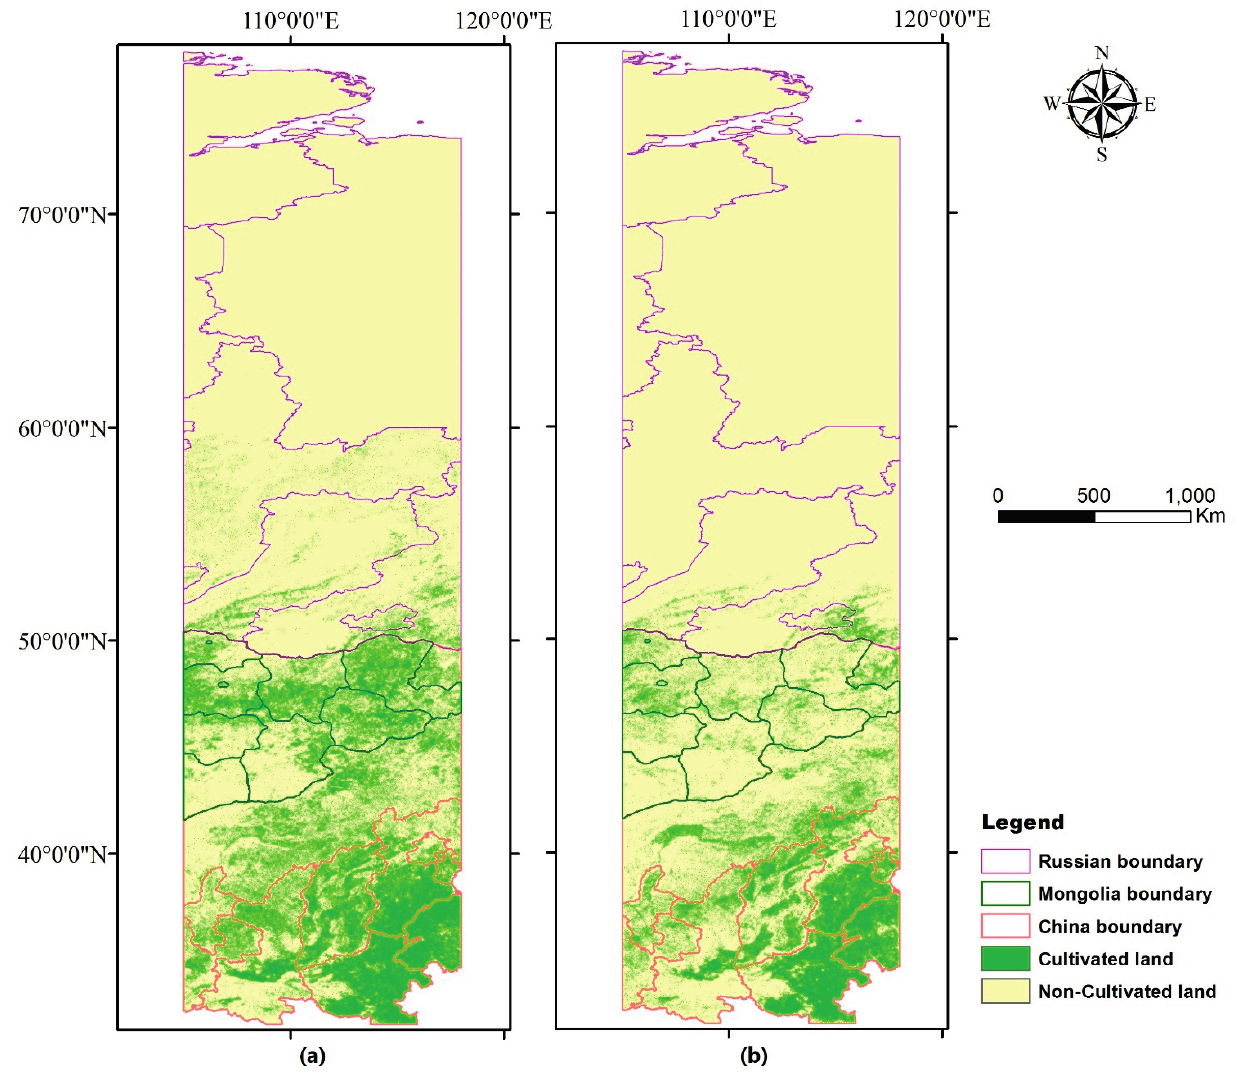
Figure 6. The distribution of cultivated land in the NSTNEA in 2000 and